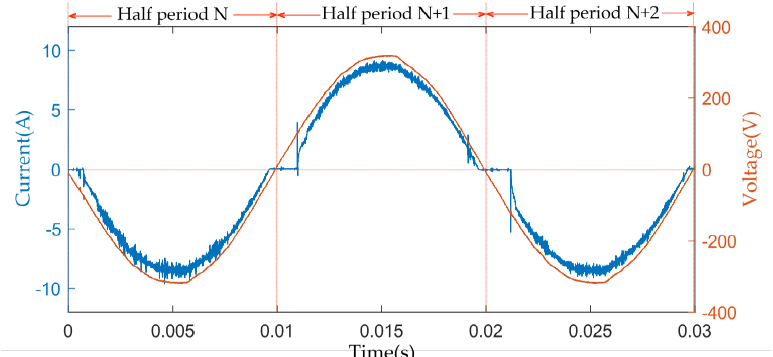
Figure 3. Divide half periods by voltage signal.